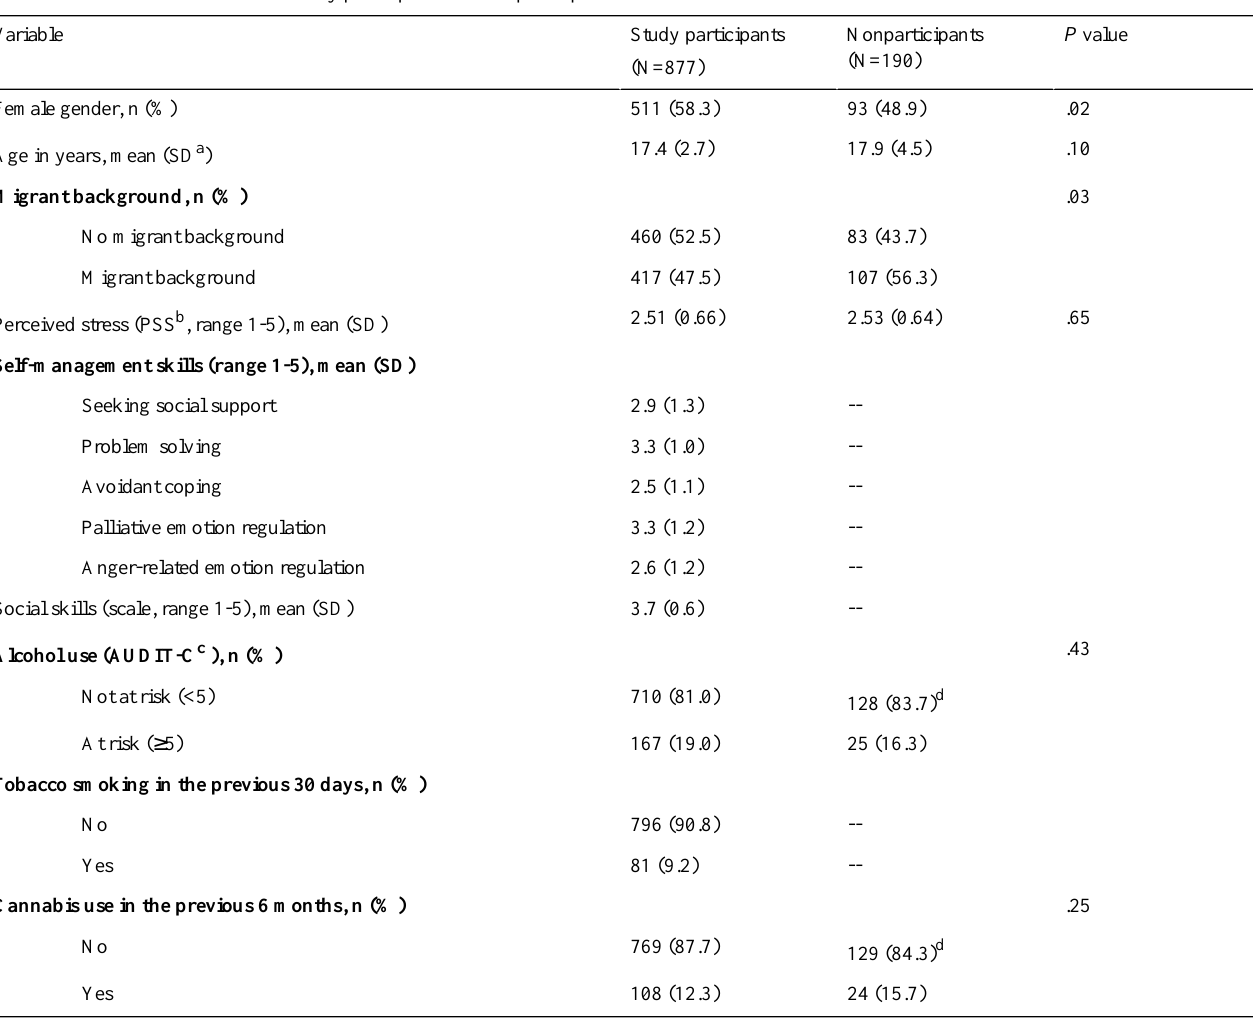
Table 1. Baseline characteristics of study participants and